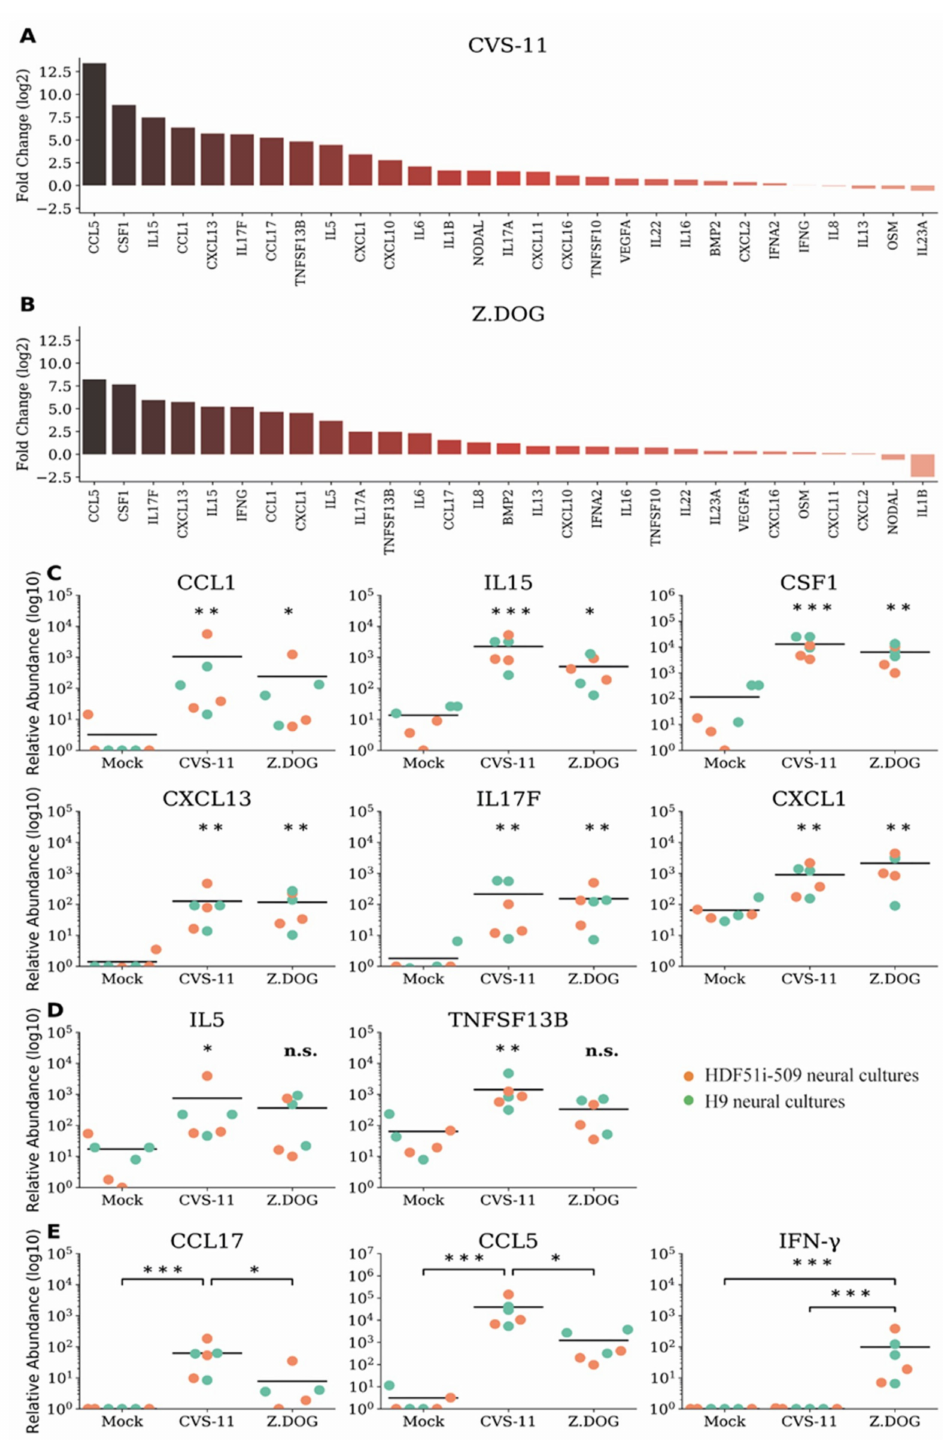
Figure 4. Gene expression profiles of chemokines and cytokines in H9- and HDF51i-509-derived human neural cultures infected with CVS-11 and Z.Dog rabies virus. H9-NPCs and HDF51i-509-NPCs were di ff erentiated for 27 days and 28 days, respectively, before infection with rabies virus. qPCR analysis of chemokine and cytokine genes (29 genes selected from initial screen of 91 genes, Supplementary Materials Table S1) in H9-NPC and HDF51i-509-NPC-derived neural cultures infected with CVS-11 and Z.Dog rabies virus for 72 h at virus:cell ratio of 1. ( a , b ) Graphs show fold change (log2) of all 29 genes screened relative to mock infection in both H9-NPC-derived and HDF51i-509-NPC-derived neural cultures. ( a ) Infection with CVS-11 and ( b ) infection with Z.Dog strain. ( c ) Graphs show